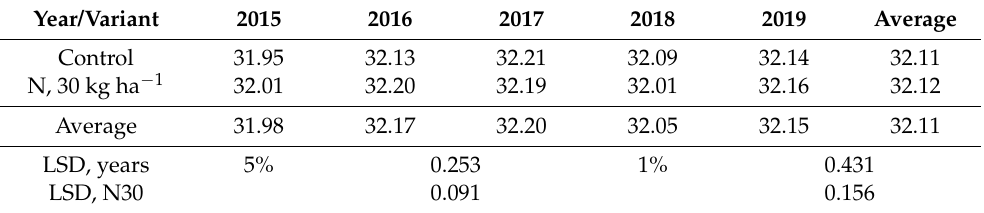
Table 6. Stalk cellulose content in (%) during